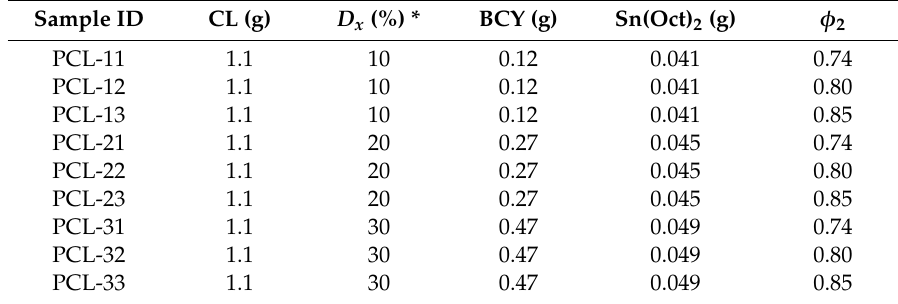
High internal phase emulsion (HIPE) formulations for the synthesis of crosslinked poly( ε -caprolactone) (PCL) sca ff